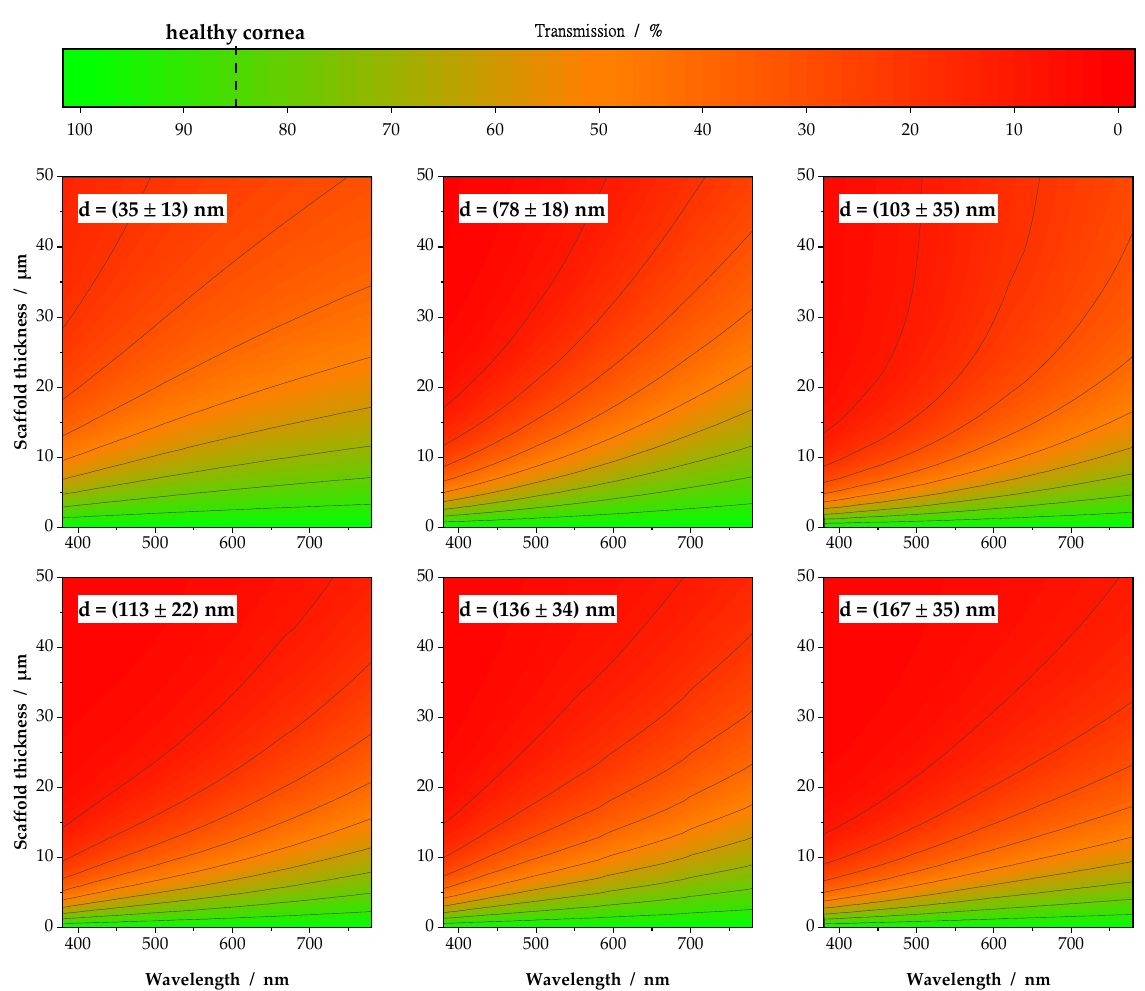
Figure 5. Resulting contour plots from the individual light transmission measurements, as shown in Figure 4. Sufficient light transmission can be observed only for thin scaffolds, as depicted by the color grading, whereby a smaller fiber diameter enhances light transmission through the scaffolds. Fiber diameter increases from top left to bottom right.